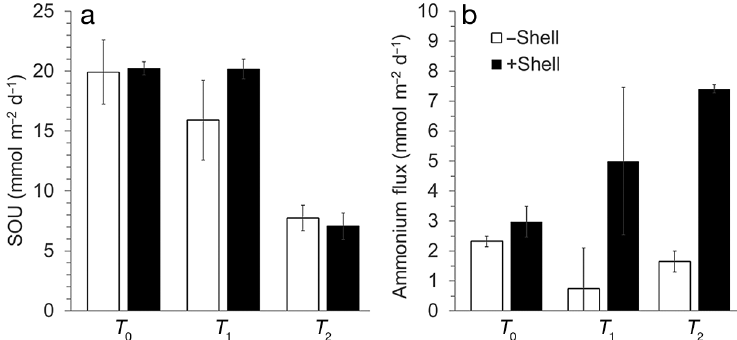
Fig. 2. Effect of presence of shell (−Shell/+Shell) on (a) sediment oxygen uptake (SOU) and (b) ammonium fluxes over time. T 0 : samples at start of experiment; T 1 : samples after 1 wk; T 2 : samples after 3 wk